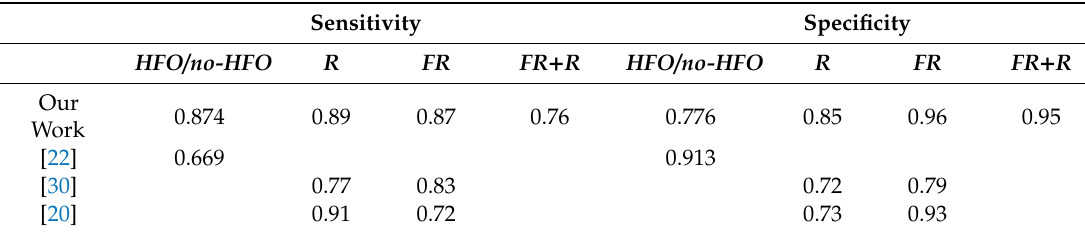
Table 2. Comparison of the obtained results with similar procedures in the